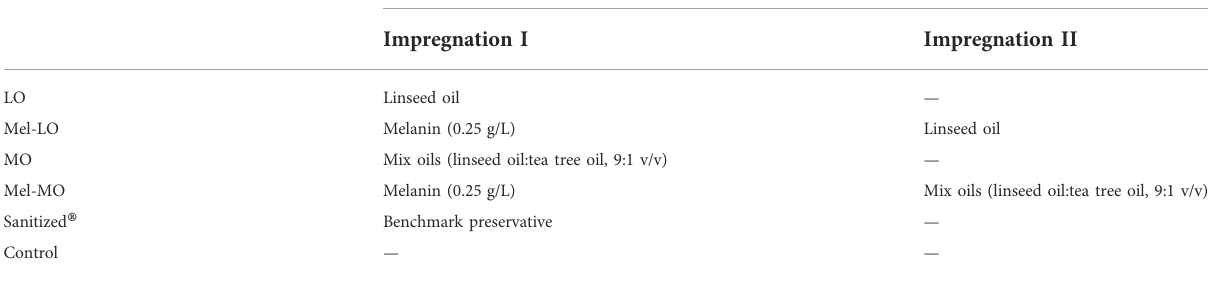
TABLE 1 Abbreviation for different